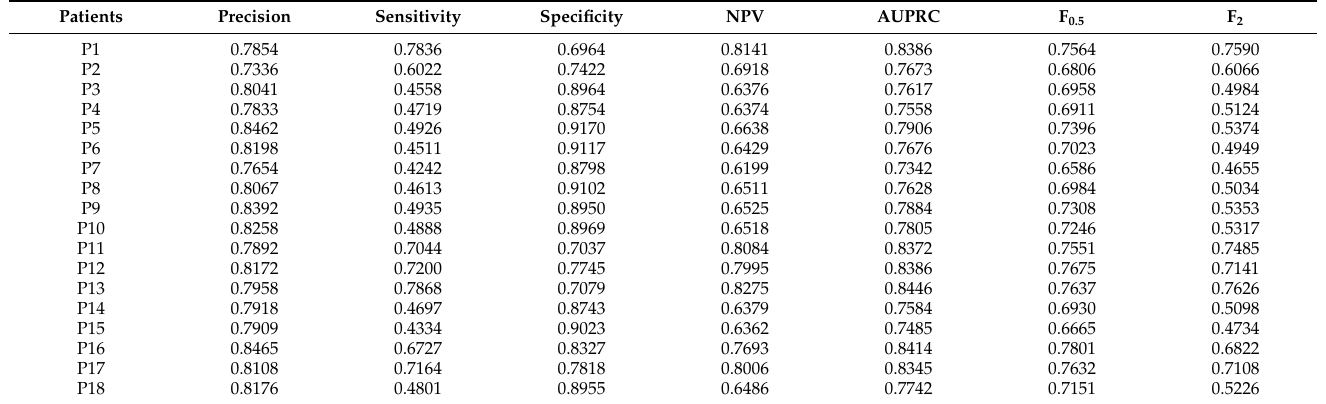
Table 4. Additional evaluation metrics ( CNN ) for all